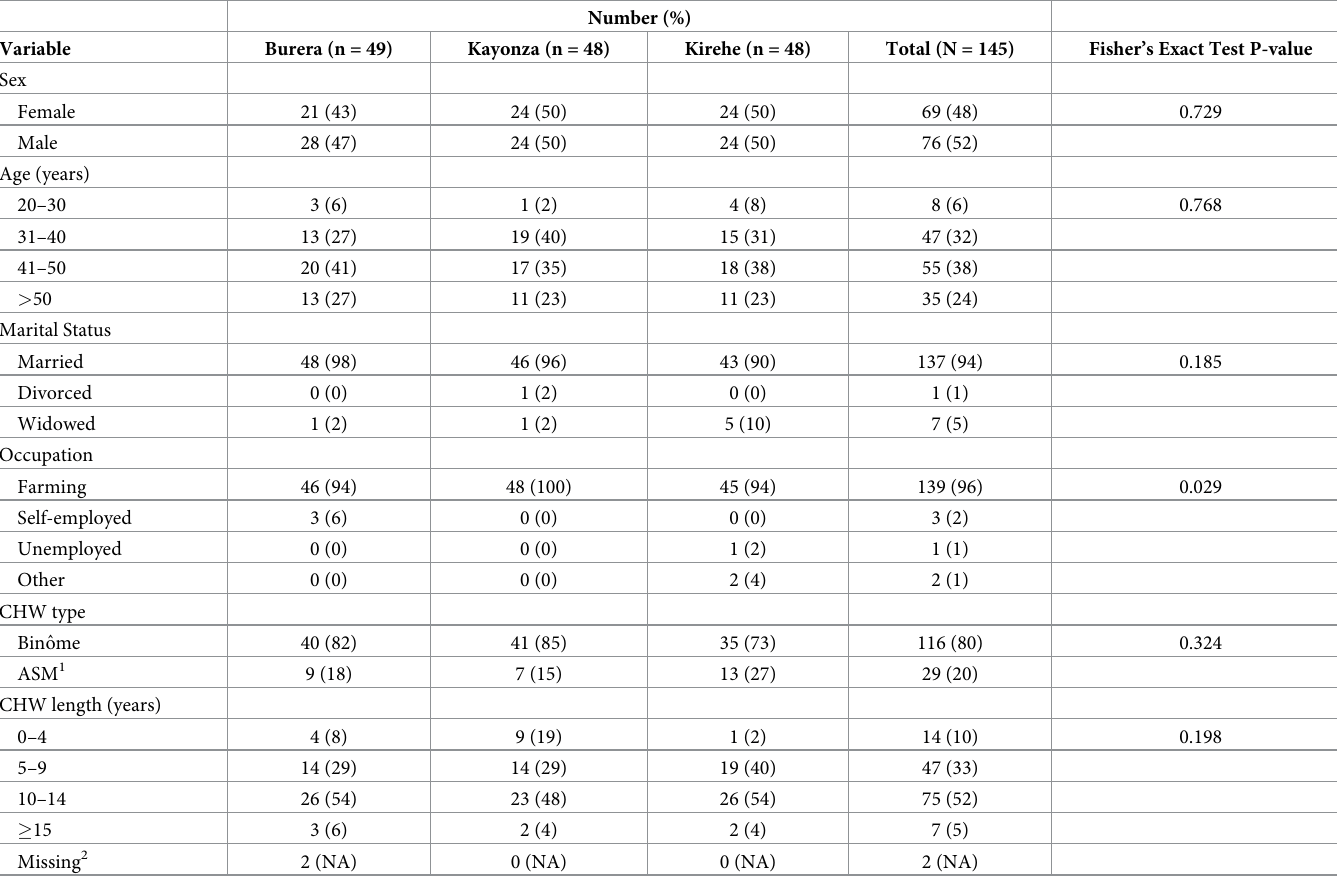
Table 2. Demographic summary of study participants engaged in community health work in three districts of Rwanda (N =